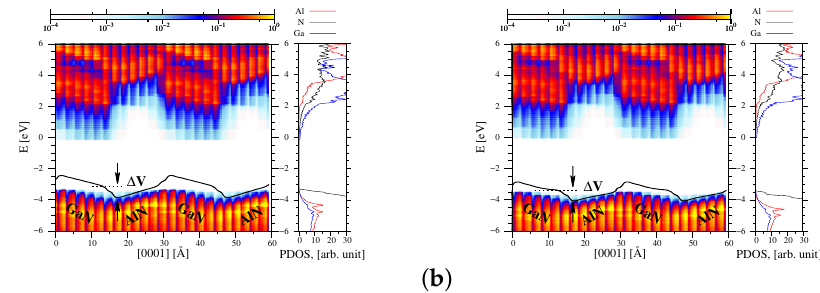
Figure 3. Energy band profiles for AlN/GaN superlattice: ( a ) strained to GaN, ( b ) fully relaxed. Left diagram—the density of states projected on the atom quantum states (PDOS), showing the spatial variation of the valence and conduction bands as a function of the AlN/GaN heterointerface height z , right diagram—PDOS associated with Al, N, and Ga atoms denoted by red, black, and blue lines, respectively. The potential jump at the interface are ∆ V = 0.76 eV and ∆ V = 0.67 eV for the strained ( a ) and relaxed ( b ) cases, respectively.